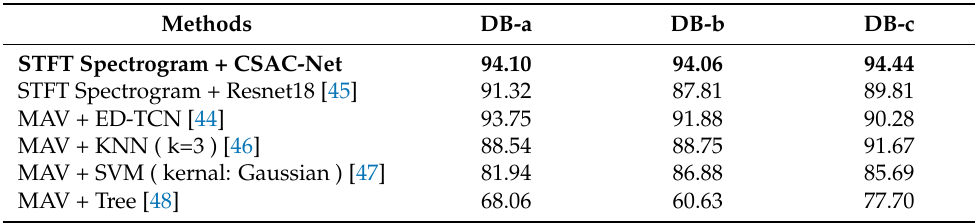
Table 2. Comparison between previous methods and the proposed CSAC-Net in terms of the accuracy (%) of traditional supervised learning classification on DB-a, DB-b, and DB-c (10 times average accuracy). The boldface number represents the best classification results.